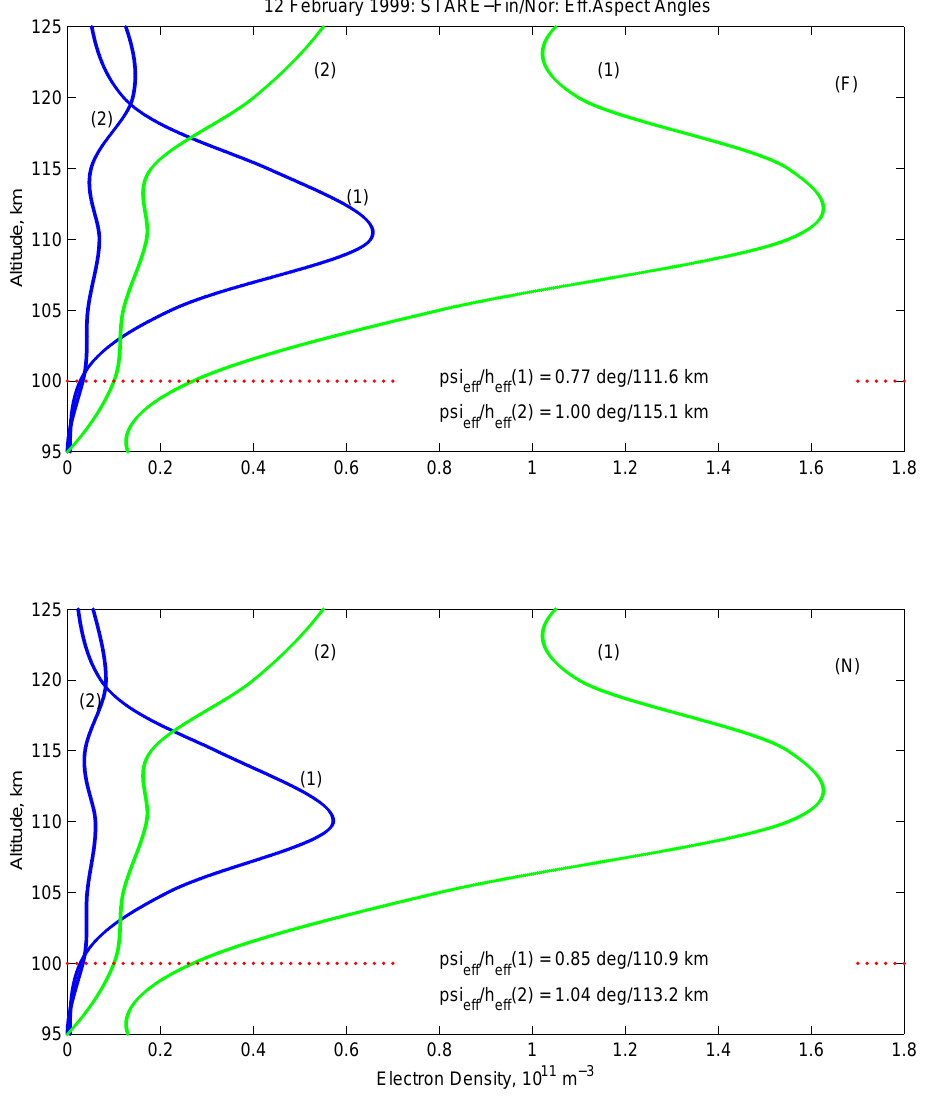
Figure 4: Uspensky et al Fig. 4. Two smoothed EISCAT electron density profiles at 02:25UT (1) and 00:50UT (2) for the periods shown in Fig. 3, green lines, and the relative backscatter volume cross sections for these profiles for the STARE-Finland (F) and STARE-Norway (N) radars; dotted red lines show the assumed altitude of the exact orthogonality. The minor differences between the (F) and (N) radar cross section profiles are due to different assumed gradients in the aspect angle change with